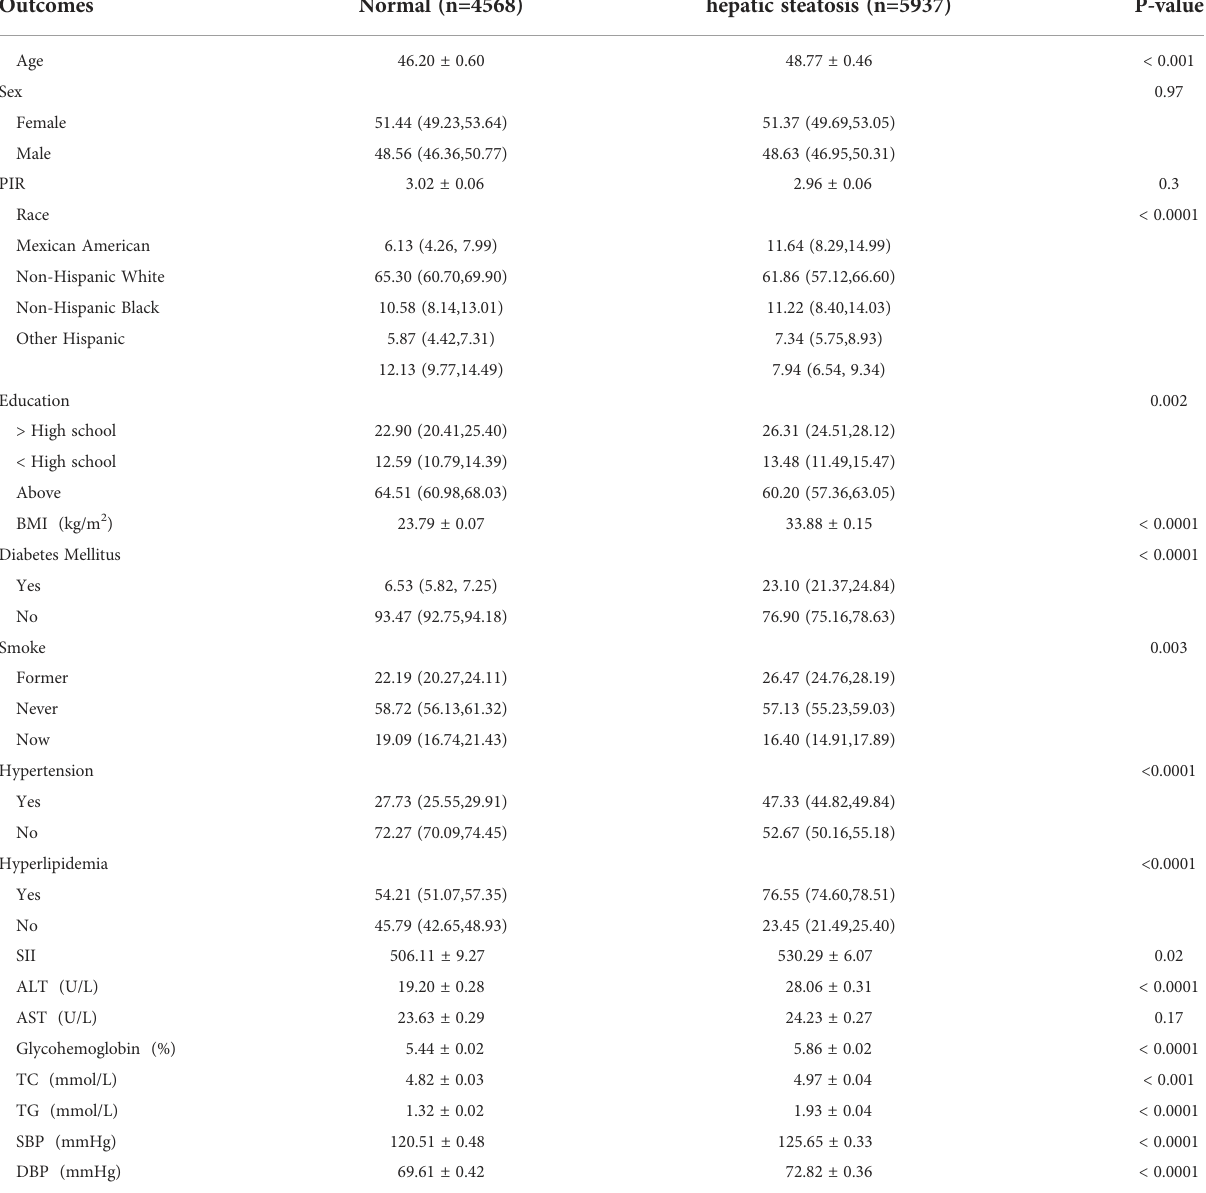
TABLE 1 Basic characteristics of participants (n = 10505) in the NHANES 2015 –